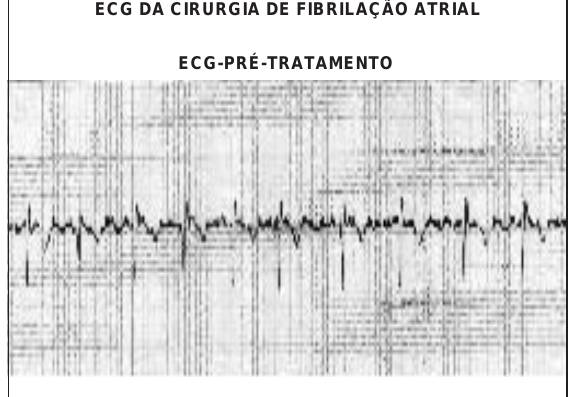
ECG DA CIRURGIA DE FIBRILAÇÃO ATRIAL